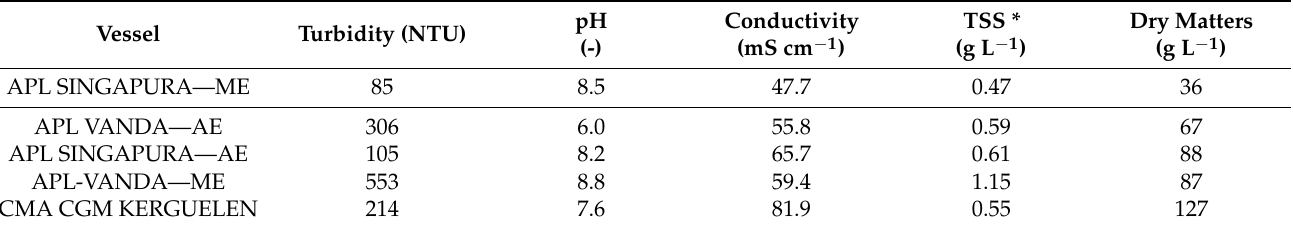
Table 1. Physical and chemical characteristics of effluents treated (TSS is made from NF EN 872 protocol and dry matter from NF EN